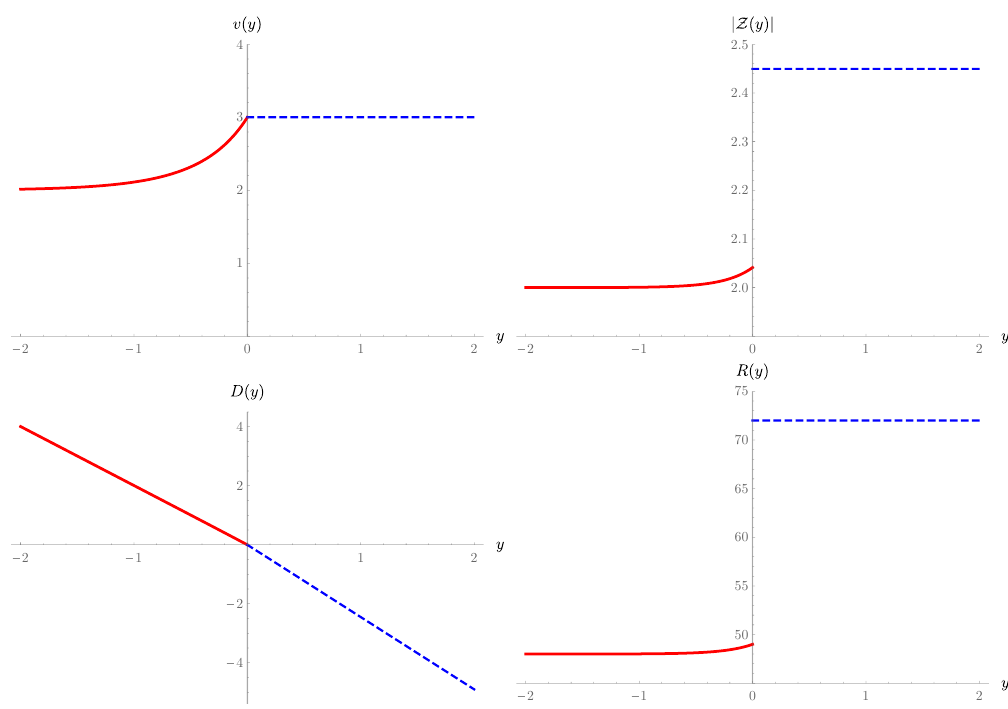
Above are depicted all the solutions to the (cid:13)ow equations (8.15), (8.18) for the same set of parameters as in (cid:12)gure 3. The solid red lines refer to the quantities in the region on the left of the membrane, while the dashed blue lines to those on the right. On the top left there is the evolution of the scalar (cid:12)eld: starting from the critical point on the left of the membrane, the (cid:12)eld v is driven towards the critical point on the right of the membrane. On the top right there is the modulus of the covariantly holomorphic superpotential jZj , which is always increasing. On the bottom left there is the warping D ( y ), which is always decreasing, using which the curvature, on the bottom right, can be obtained. As expected from the AdS vacua, the curvature is at a (cid:12)xed positive value when the (cid:12)eld v reaches the vacua and, even though not explicitly shown here, is singular at the point y = 0. In the (cid:12)gures y is jZ (cid:3) j (cid:0) 1